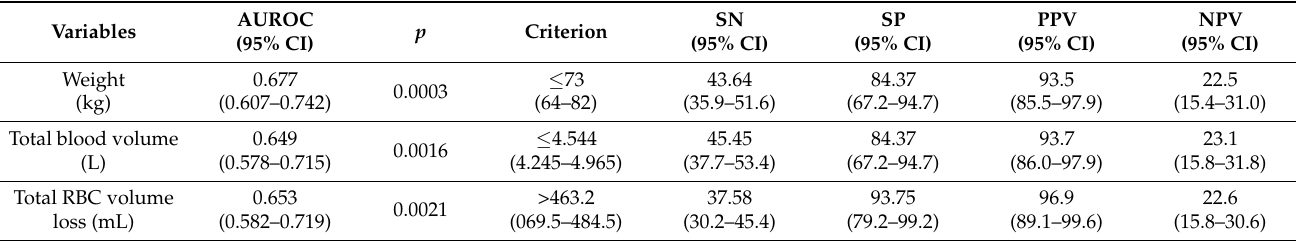
Table 3. Receiver operating characteristic (ROC) parameters for weight, total blood volume and total RBC volume loss in detection of patients with postoperative anemia after hip or knee